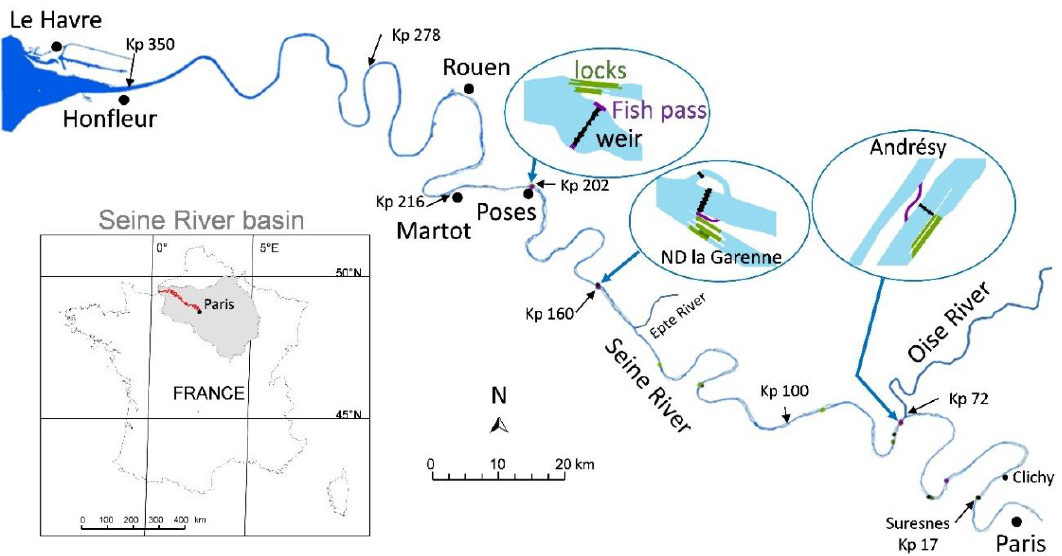
Figure 1. The spatial extent of the studied Seine River from the sea to Paris and its location (in red) in the Seine River Basin in France (thumbnail). The estuary extends up to Poses (kp 202). Some kilometric points are indicated from Paris (kp 0) to Honfleur (kp 350). Zoom-ins on some physical features are illustrated, namely three navigation weirs, locks, and fish passes (2018). Table 1. Species characteristics for mature migrating individuals. CR: critically endangered; EN: endangered; VU: vulnerable; NT: nearly threatened. Migratory periods were defined using video- counting data (2008–2018) at the Poses fish pass station. Adapted from [37,38], completed: ◦ [39], * [40]. Atlantic salmon ages are 1SW: one winter at sea, 2SW: two winters at sea. Allis